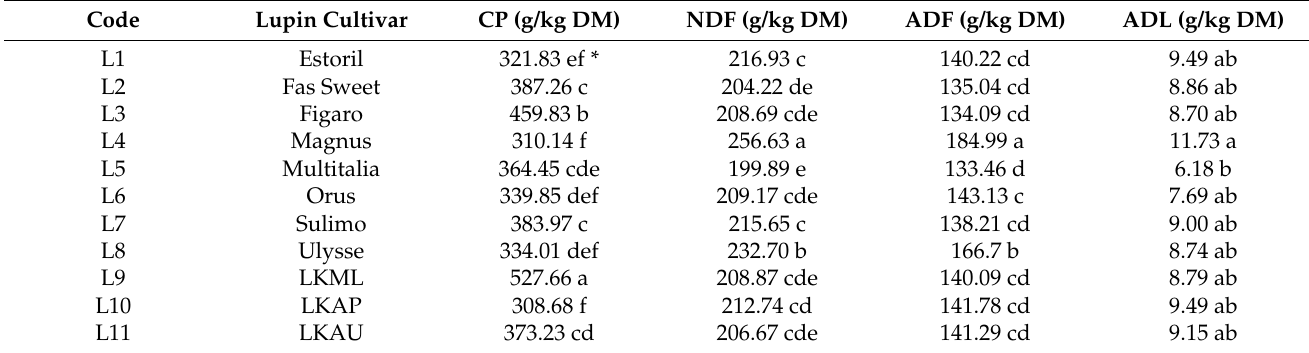
Table 7. Nutritional traits of lupin cultivars and advanced